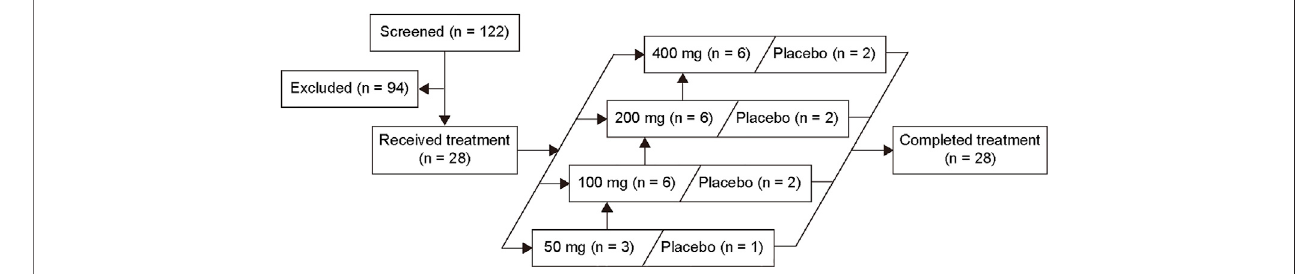
FIGURE 1 | Volunteer disposition.